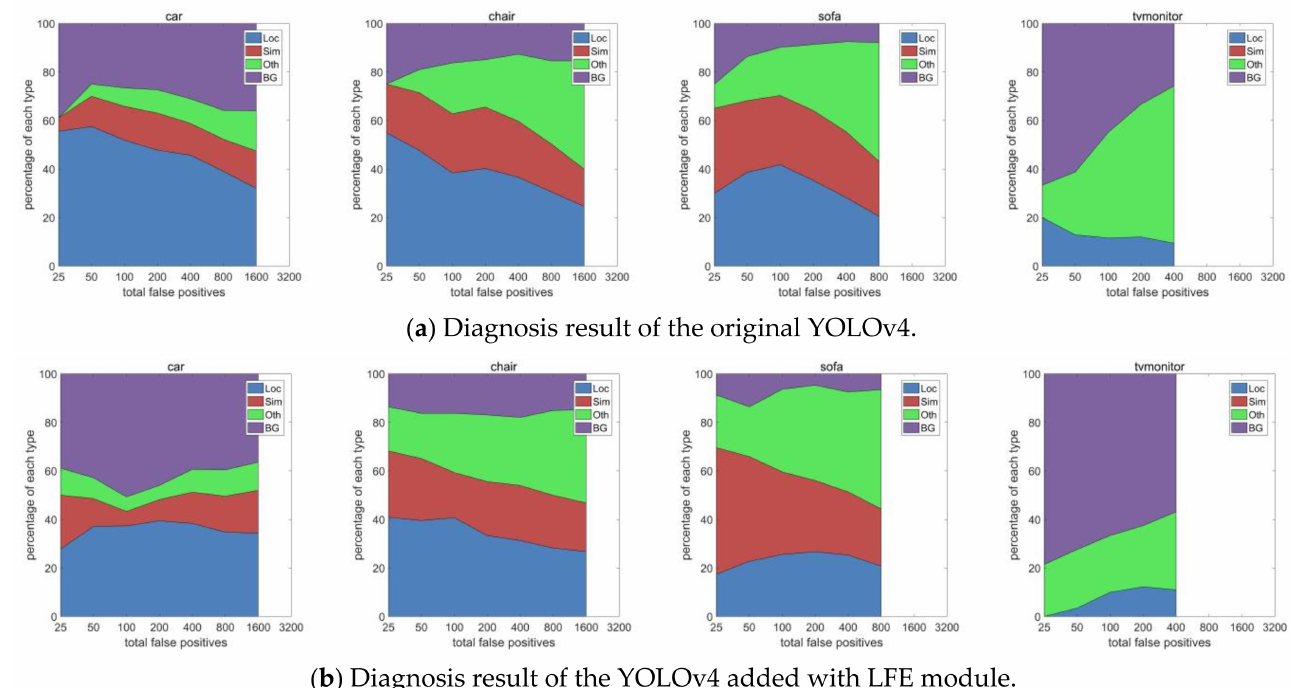
Figure 5. Error distribution and diagnosis diagram. The first row is the diagnosis result of the original YOLOv4, and the second row is the diagnosis result of the YOLOv4 added with the location feature extraction structure. Loc: position error; Sim: similarity error; BG: background error; Oth: other